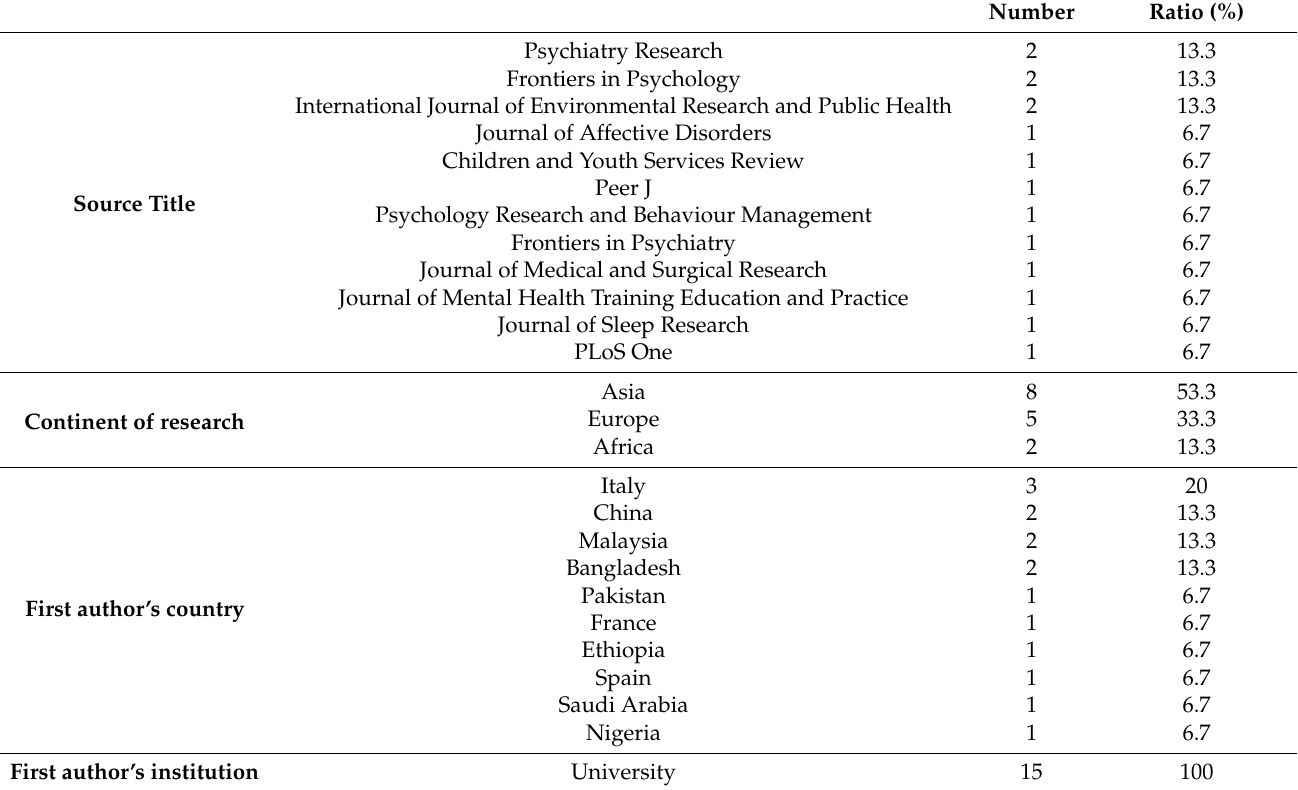
Table 2. Publishers of studies included in the present narrative